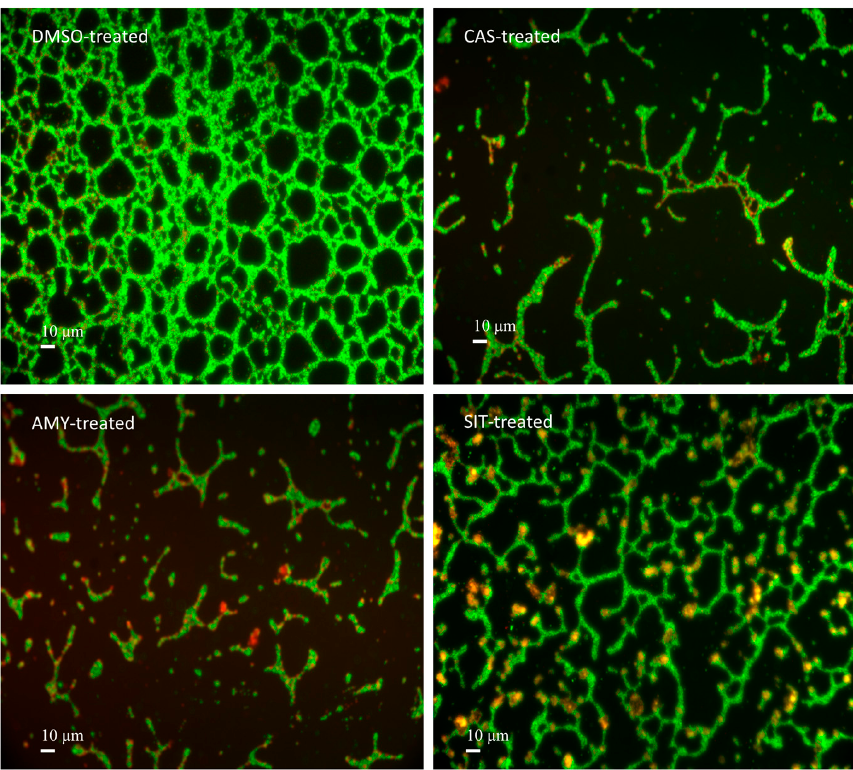
Figure 7. P. aeruginosa PAO1 biofilm phenotypes as affected by cassipourol or β -sitosterol or α -amyrin. P. aeruginosa PAO1 cells were incubated statically at 37 ◦ C for 24 h for biofilm formation in presence of DMSO 1%, or cassipourol (CAS) or β -sitosterol (SIT) or α -amyrin (AMY) at 100 µ M. Cells were visualized after staining with SYTO-9 (green fluorescence for living bacteria) and propidium iodide (red fluorescence for dead bacteria) furnished in the LIVE/DEAD Bac Light kit. Fluorescence microscopy was achieved by using a Leica DM IRE2 inverted fluorescence microscope using a 40 × objective lens and images were false-colored and assembled using Adobe Photoshop.